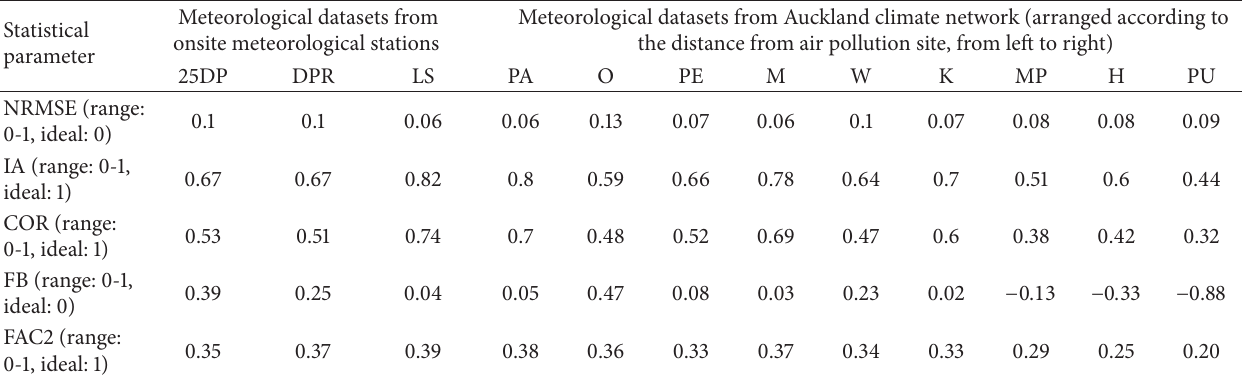
Meteorological datasets from Auckland climate network (arranged according to the distance from air pollution site, from left to right)